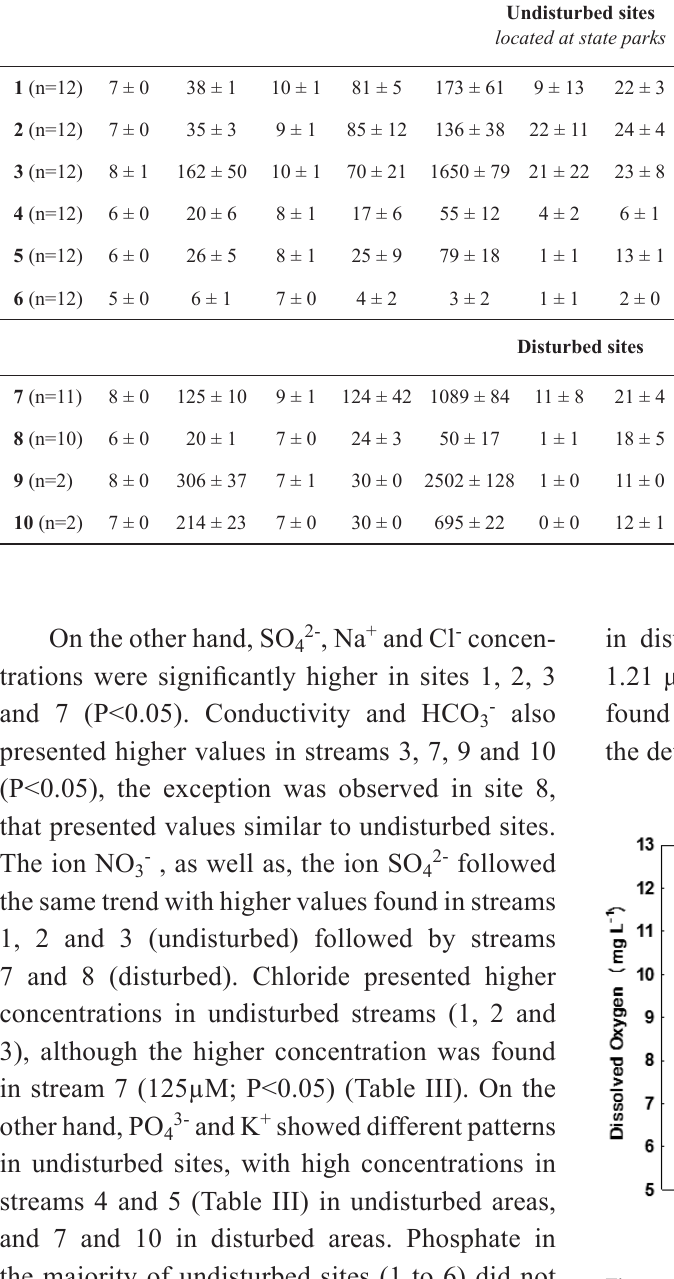
Figure 3 - Dissolved oxygen concentration (mg.L -1 ) measures at undisturbed (1, 2, 3, 4, 5, 6) and disturbed sites (7, 8, 9, 10).